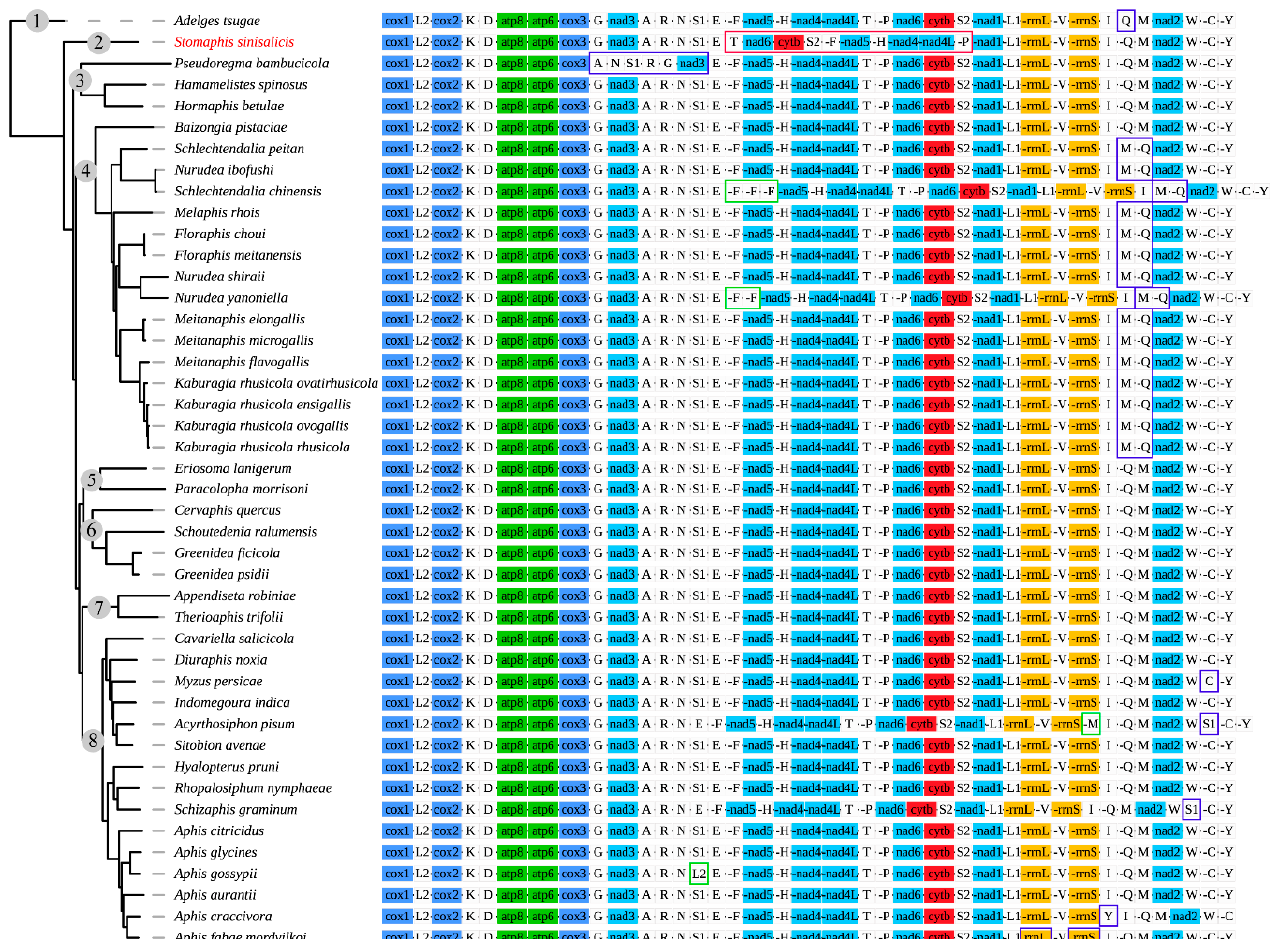
Figure 4. Gene arrangement in mitochondrial genomes of aphids (including Adelges tsugae ). Numbers labeled on clades of the left phylogenetic tree indicate different family, subfamily or tribe of aphids, which correspond to clades in the phylogenetic tree below, 1: Adelgidae; 2: Lachninae; 3: Hormaphidinae; 4: Fordini (Eriosomatinae); 5: Eriosomatini (Eriosomatinae); 6: Greenideinae; 7: Calaphidinae; 8: Aphidinae. Within the right gene arrangement image, the color blocks represent different categories of genes, dark blue: cytochrome oxidase complex; turquoise: NADH dehydrogenase complex; red: cytochrome b; ginger: ribosomal RNA genes; grey white: transfer RNA genes. The transfer RNA genes are indicated by the corresponding capital letters. Putative gene rearrangement events identified by CREx analysis (with the Drosophila yakuba as referenced ancestral gene arrangement) are marked by different color boxes. The predicted tandem-duplication-random-loss events (TDRL) occurred in Stomaphis sinisalicis are indicated with red box; the other gene rearrangement events (including the transposition, inversion, inverse transposition) are indicated by blue box; gene duplications are labeled with green boxes. Non-coding region was excluded from the analysis.